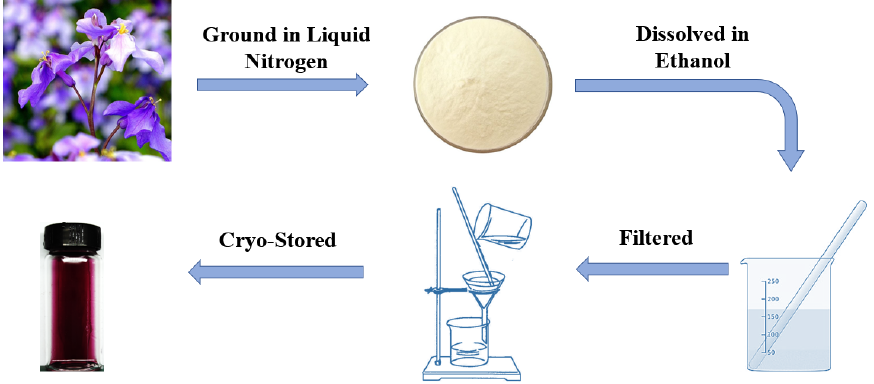
Figure 1. Formulating procedure of F. orchid indicator.